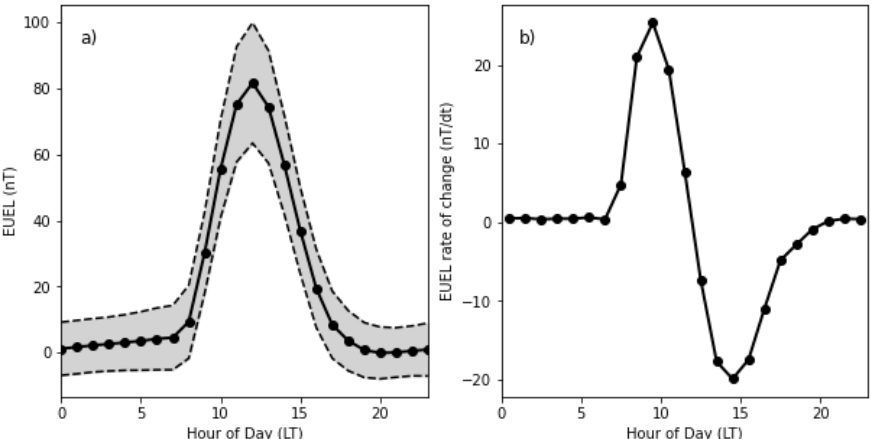
Figure 11. ( a ) Hour of day mean of EUEL at Davao, Philippines (black line and dots) superposed over EUEL standard deviations (dashed line and gray fill). ( b ) Hour-of-day mean rate of change (dEUEL/dt) which is used as a measure of the temporal variation in EEJ strength. Means are calculated over the period January 2016 – December 2019.